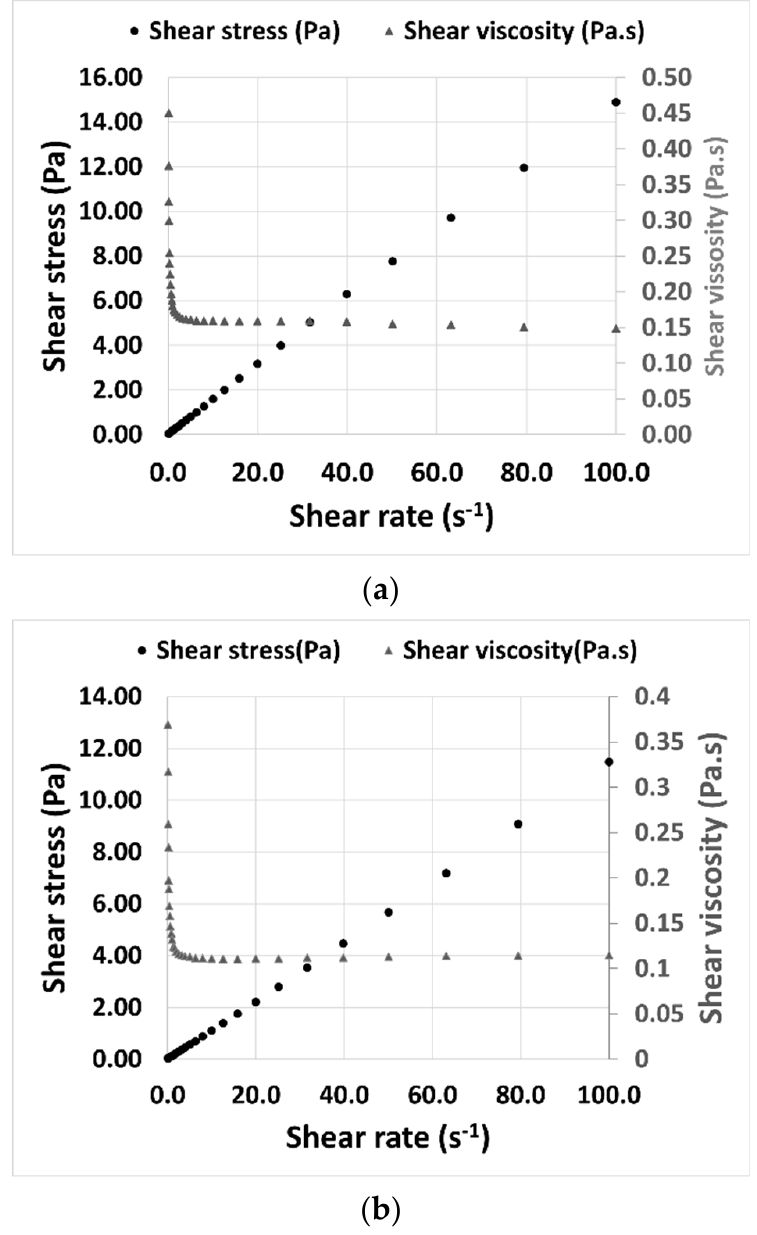
Figure 6. Shear stress and shear viscosity versus shear rate for the ( a ) CLP−THELES and ( b ) TLB−THELES. The rheological behavior of the THELES with temperature was studied between 10 ◦ C and 60 ◦ C (Figure 7). For both THELES, the viscosity decreased with temperature until a certain temperature around 40 ◦ C and 35 ◦ C for CLP-THELES and TLB-THELES, respectively. The solubility was determined in phosphate buffer (pH = 7.4). The solubility of both APIs in the THELES was much higher than the respective crystalline API (Figure 8). For chlorpropamide, the increase was 188 times, from 2.1 mg · mL − 1 of crystalline CLP